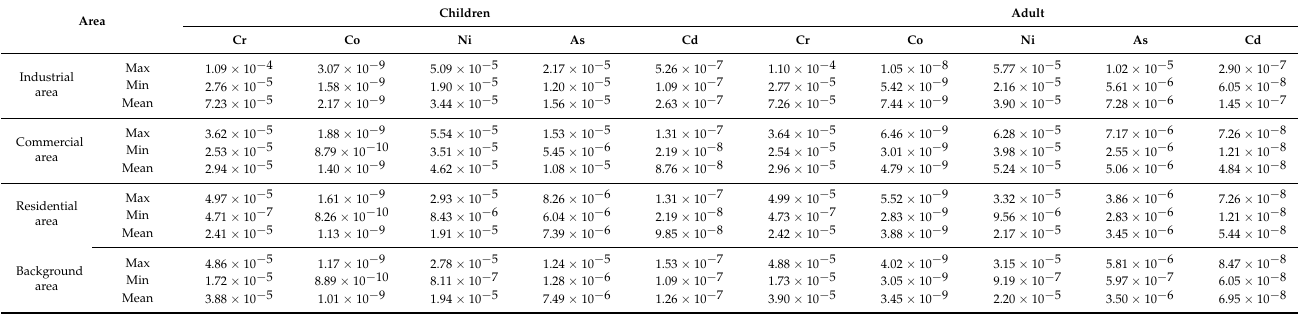
Table 8. CR i for children and adults in various